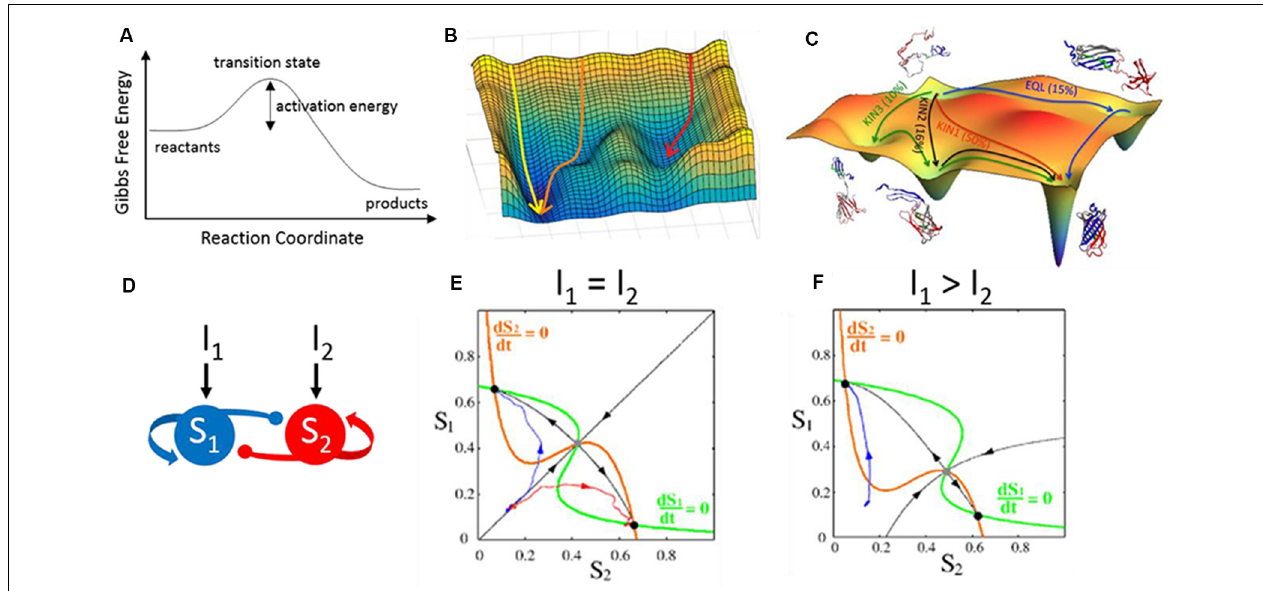
FIGURE 6 | Energy landscapes across disciplines. (A) Gibbs free energy curve illustrating the transformation of reactants to products across an energetically unfavorable transition state. This curve depicts a reaction occurring within a single dimension. (B) Reactions occurring within two dimensions can be depicted as an energy landscape or potential energy surface. Shown here are three simulations (arrows) along a hypothetical two-dimensional energy landscape. The initial conditions and contours of the landscape determine the simulation trajectories, which flow from states of high (peaks) to low (troughs) free energy. (C) A simulated energy landscape for the re-folding of denatured green fluorescent protein (GFP), with multiple potential pathways (arrows) undertaking different partial folding states. (D–F) An analogous form of energy landscapes, used here to model neural circuit activity. (D) The structure of the circuit model is two populations (S1 and S2) which self-excite (arrows) and cross-inhibit (circles). Each population can be driven by external inputs (I1 and I2). (E) A phase plane representation of the activities of S1 vs. S2 provides an activity landscape of the network. Critical features of this landscape are the fixed points demarcated at the crossings of the nullclines (orange and green lines). Stable fixed points (black dots) are analogous to troughs in an energy landscape. The unstable fixed point in this example (gray dot) would have the shape of a saddle in an energy landscape: sloping down towards the fixed point (black arrows towards) and sloping down away from the fixed point (black arrows away). The two simulations shown in blue and red have the same starting point but diverge from each other and converge into the two stable fixed points. (F) Changing the inputs alters the landscape, which now (I1 > I2) favors activity trajectories towards the top-left fixed point. Panel (C) is reproduced with permission from Reddy et al. (2012), panels (E,F) are reproduced with permission from Wong and Wang (2006), copyright 2006 Society for